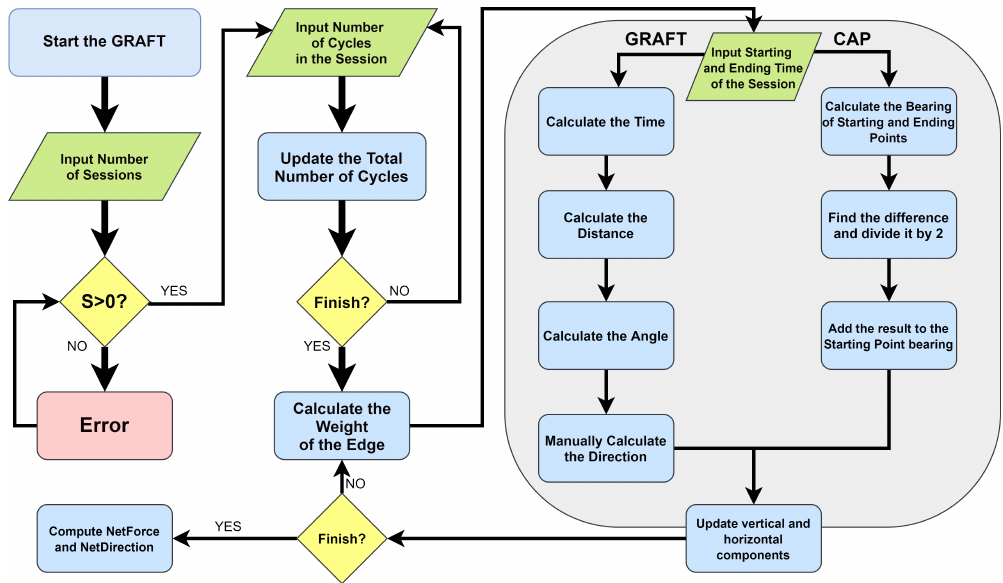
Figure 9. The FlowChart of the GRAFT model including the place of the Clock-Angle-Problem